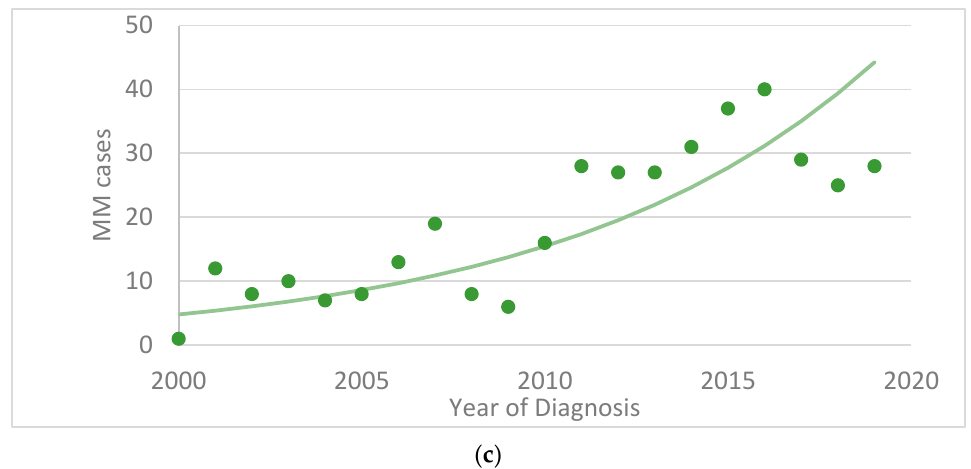
Figure 1. Number of cases and APC-modeled regression line graphed over time for ( a ) cutaneous malignant melanoma (CMM), ( b ) Merkel cell carcinoma (MCC) and ( c ) mucosal melanoma (MM).